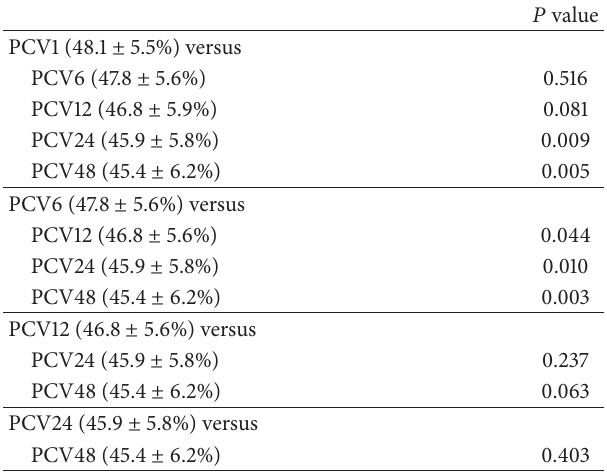
Table 2: Mean (SD) packed cell volume (PCV) at 1hr, 6hrs, 12hrs, 24 hrs, and 48 hrs after transfusion.